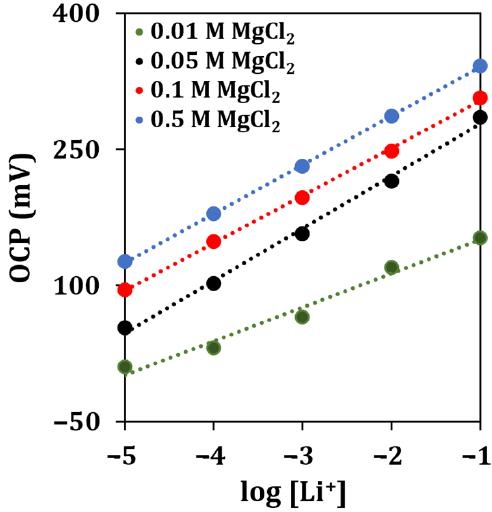
Figure 5. Lithium calibration curves obtained with different concentrations of the supporting electrolyte solution by OCP measurements (n = 5).